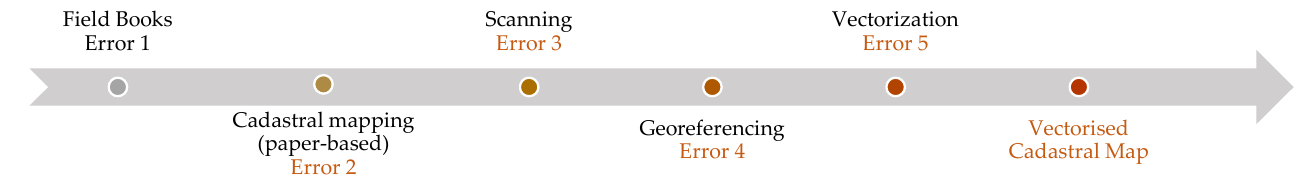
Figure 4. Digitisation of analogue cadastral maps in North Macedonia and Slovenia. Field books with measurement data were not considered in this process.